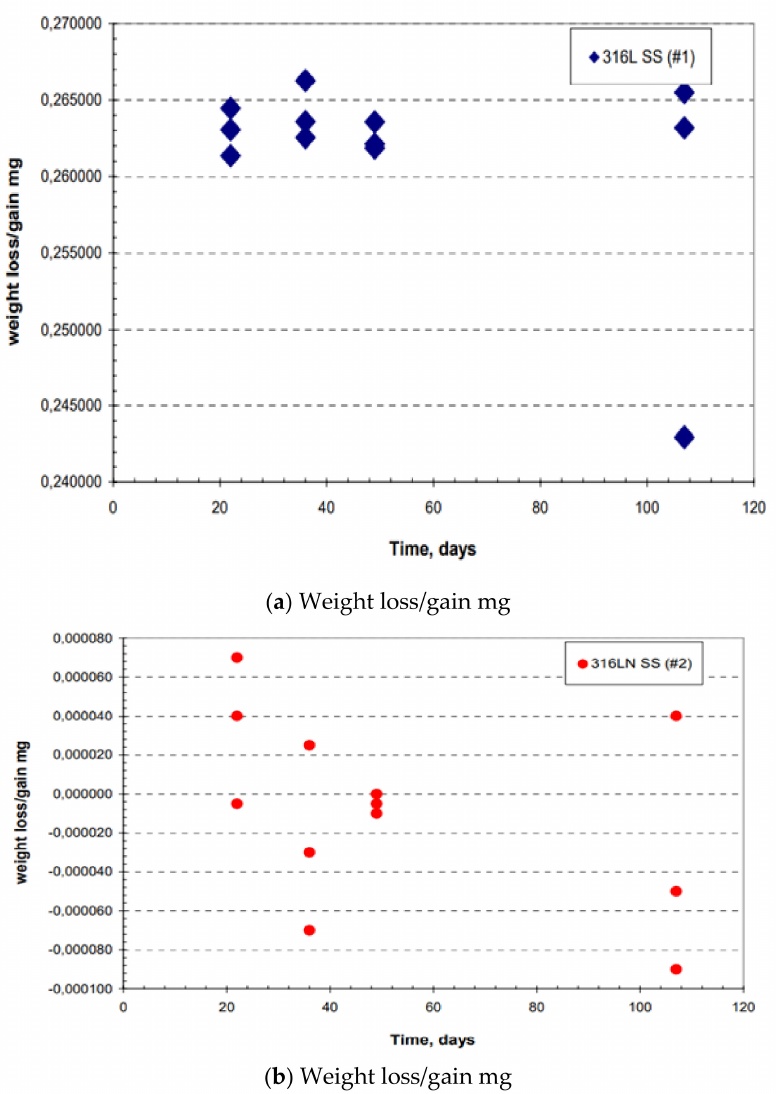
Figure 8. Weight gain/loss of creviced samples as a function of exposure time in simulated BWR environments under irradiation of 316L ( a ) and 316LN SS ( b